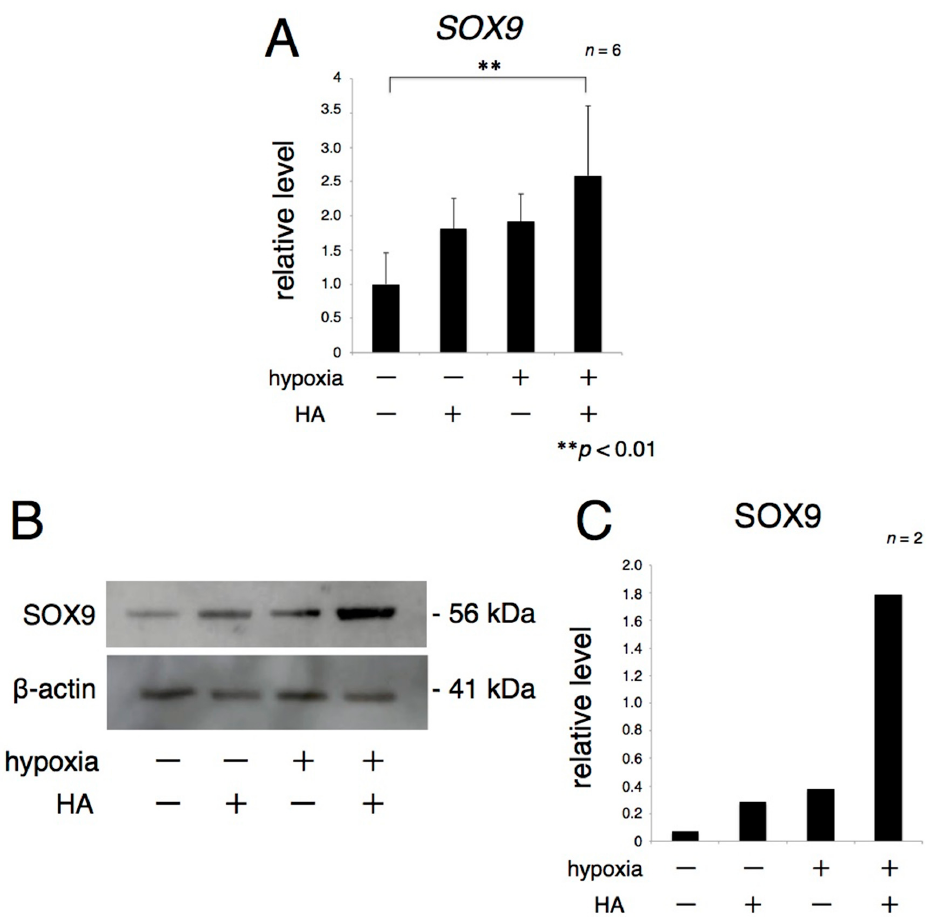
Figure 2. Exogenous HA promotes the expression of transcription factor upstream of ECM protein under hypoxic conditions. Rat articular cartilage was cultured in the presence of 4000 µ g/mL HA for 72 h under hypoxia (1% oxygen). SOX9 mRNA expression was analyzed by real-time RT-PCR ( A ); and SOX9 protein expression was analyzed by Western blotting ( B , C ). ** p <